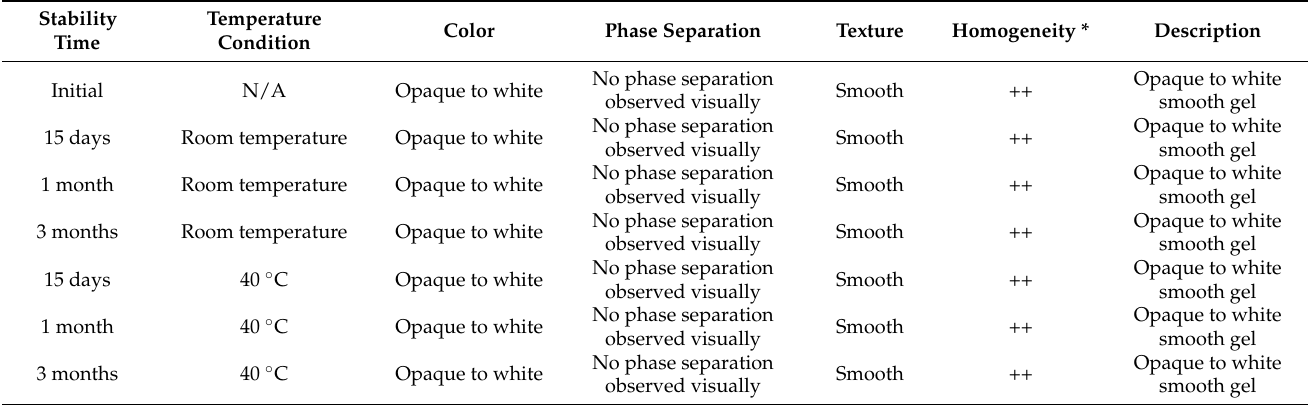
Table 13. Physicochemical stability properties of desoximetasone niosomal gel